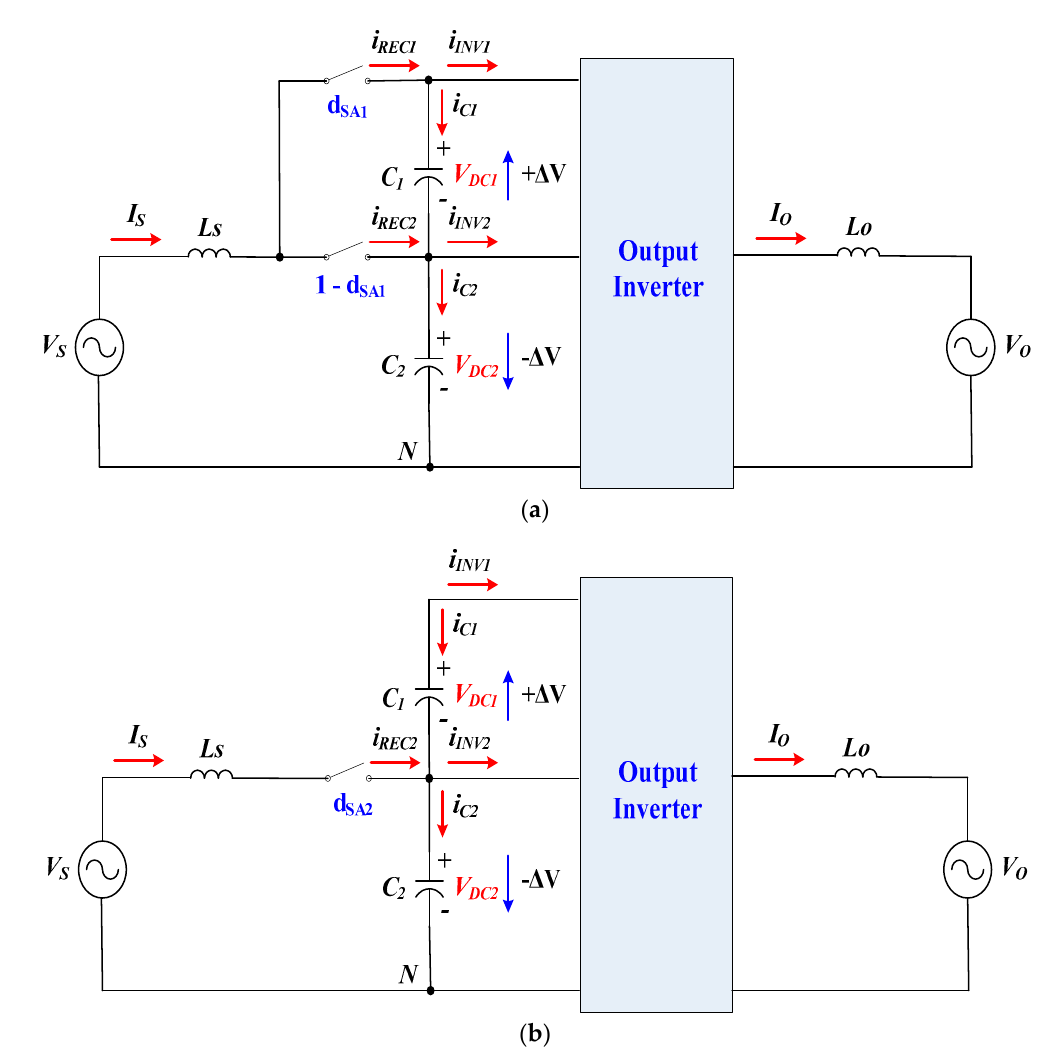
Figure 7. Simplified equivalent circuits of the five-level OCC MV Regen-Load. ( a ) In region I; ( b ) In region II.